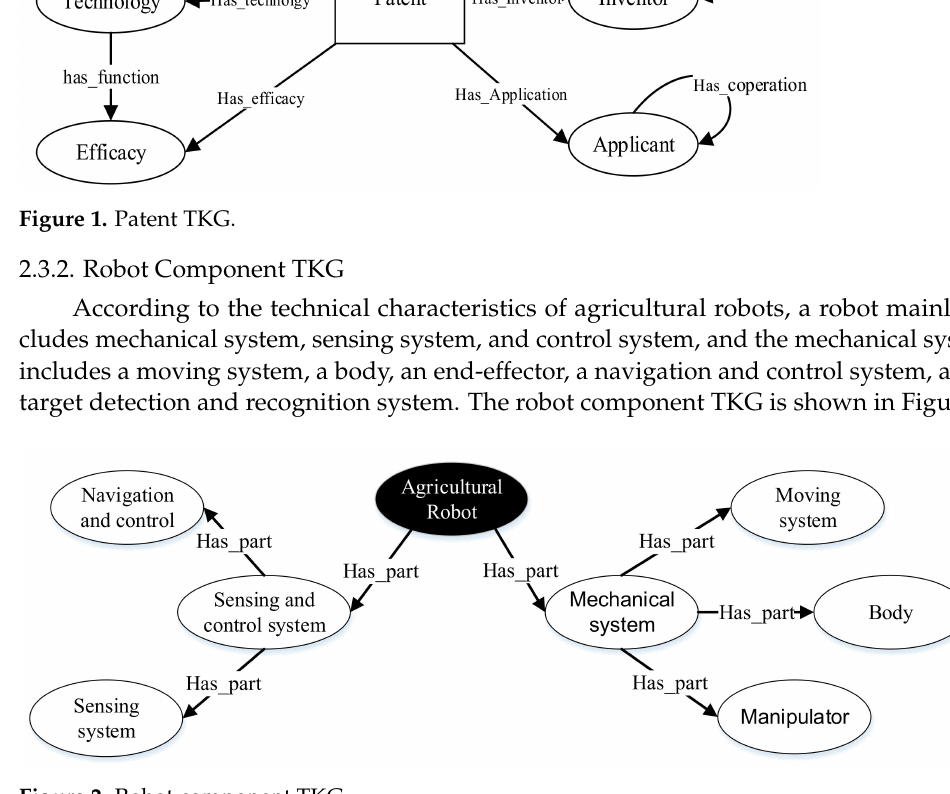
Figure 2. Robot component